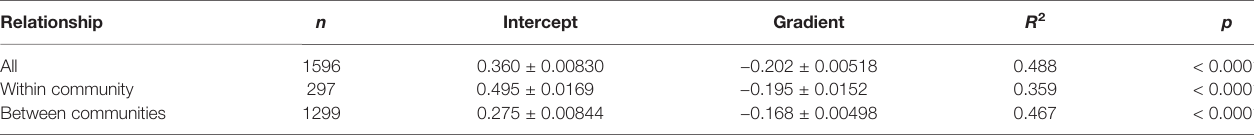
TABLE 5 | Summaries (number of data points in subset n , intercept and gradient of linear model, adjusted- R 2 and p -value) of the simple linear models fi tted to the correlation estimate with mean niche distance as predictor variable. Relationship n Intercept Gradient R 2 p All